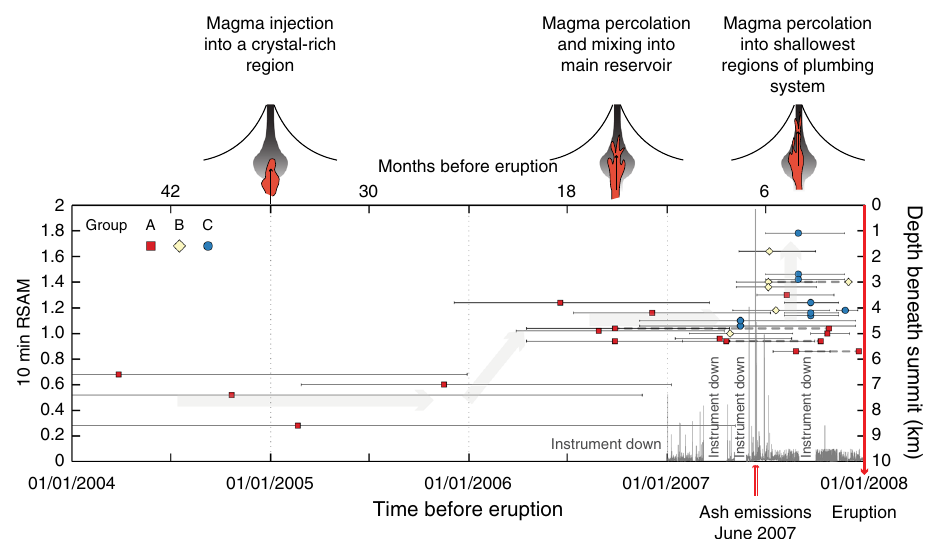
Fig. 6 Combined geochemical, seismic, and observed datasets prior to the 2008 eruption. We observe that shallower pressures are recorded as the volcano gets closer to eruption. Also note that peak seismicity, ash-venting and some timescales from the crystals overlap, probably re fl ecting gas and magma movement towards the surface. Other crystals post-date the seismicity peak by a few months and may indicate that there is a reaction time for the crystal-rich system to record the processes of melt movement or/and that fi nal melt movement towards the surface was aseismic. Also shown is a schematic cartoon showing the proposed timeline of magmatic processes is shown above. Gaps in the 10 min RSAM data indicate when the instruments were not collecting data. Grey arrows in the background show the general magma migration of magma path. Symbols connected by a dotted line show timescales for the complex crystals. Error bars show the uncertainty on the diffusion timescales based on the discrepancy from the DIPRA